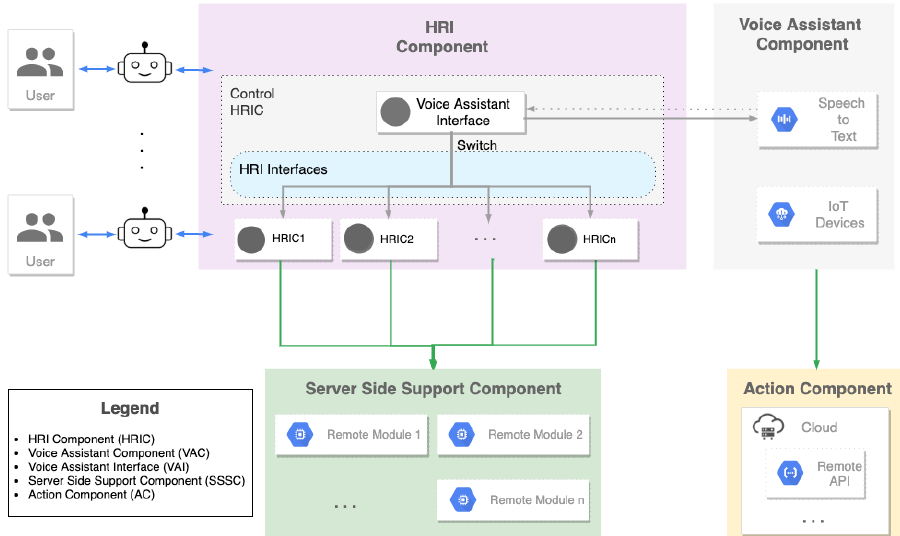
Figure 1. Proposed abstraction layer. The HRIC interacts with the user and sends the user’s audio to the VAC. The VAC decides which modules should be triggered according to the input audio. It sends to the HRIC either a string indicating which HRIC needs to be called or the result of the voice assistant cloud (if the user asked something in the open domain). Every application is generally composed of one HRIC, uploaded into the robot, which can have an associated SSSC, residing in the cloud and that can be shared among all the robots. Actions can work without an associated HRIC. Several HRIC, SSSC, and Actions can be